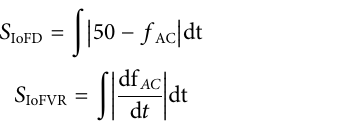
Trial and error (Xiong et al.,